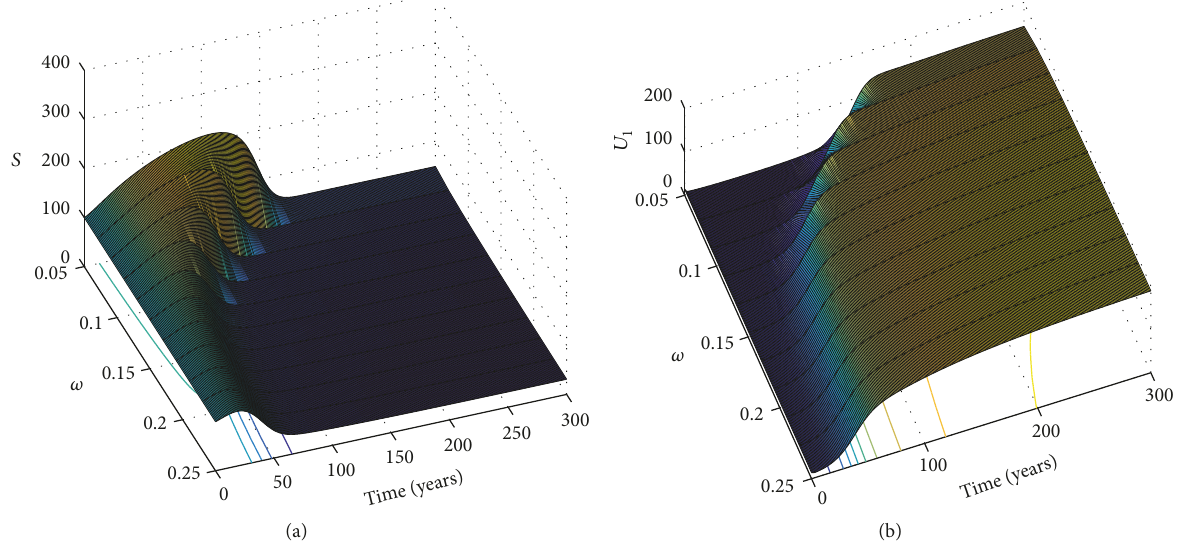
Figure 6: (a) and (b) show the effect of increasing the parameter 𝜔 that accounts for the extent of saturation of treatment when 𝑅 0 > 1 . Parameters used are the same as in Figure 5(a) except 𝑝 = 0.46 and Λ = 3 corresponding to 𝑅 0 = 1.4855 >